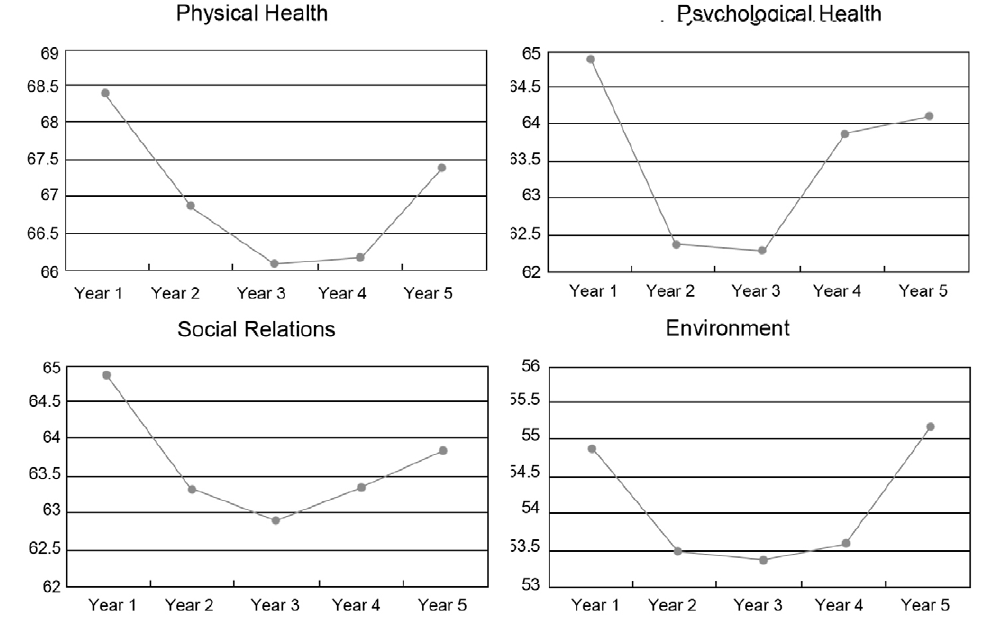
Figure 4. Scores of each domain for nursing.